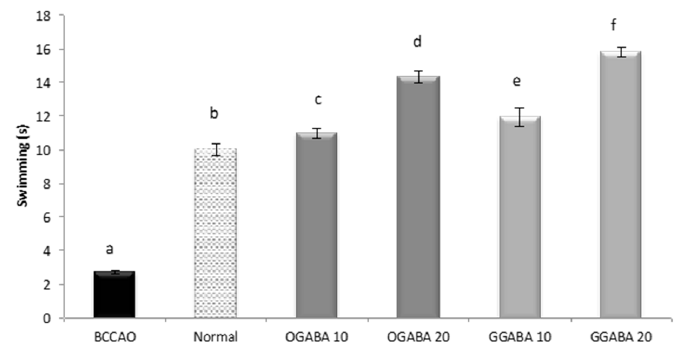
Figure 4. Effects of oral administration of OGABA and GGABA extracts on swimming time in forced swimming model. Data are mean(s) ± SD ( n = 7); different letters indicate statistically significant differences ( p < 0.05) between the two groups.